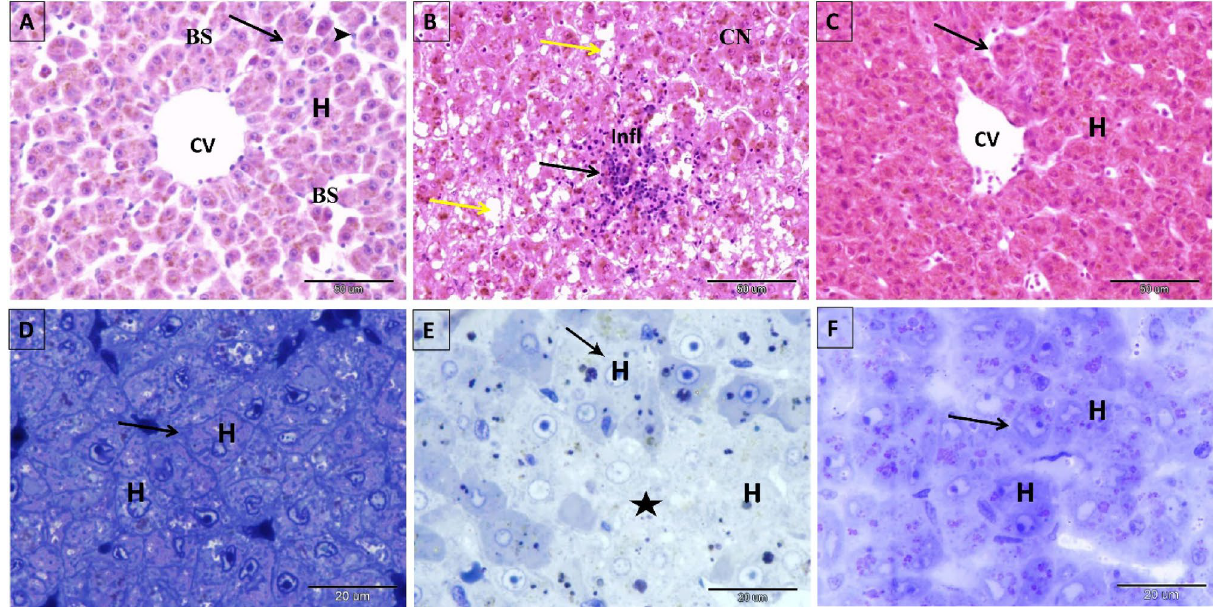
Figure 2. Photomicrograph of paraffin ( A – C ) and semi-thin ( D – F ) sections in the liver of control, 4-NP-intoxicated, and 2.5% NSS treated groups. ( A ) Control liver sections displaying healthy hepatocytes arranged in hepatic cords radiating from the central vein (CV) and were separated by blood sinusoids (BS), which were lined by endothelial cells (arrow) and kupffer cells (arrowhead). Hepatocytes (H) appeared as polyhedral cells with acidophilic cytoplasm and a vesicular, spherical nucleus in the center. ( B ) 4-NP-intoxicated liver section showing hepatocytes with widespread fatty degeneration as clear, small vacuoles filling the majority of hepatocytes’ cytoplasm (yellow arrow). Other hepatocytes exhibited stages of coagulative necrosis, which are characterized by deeply stained acidophilic cytoplasm and pyknotic, karyorrhexis, or nuclei loss (CN). A mononuclear inflammatory cell infiltration (infl) confirms the presence of acute hepatitis (black arrow). ( C ) The hepatic structure, hepatocytes (H), and central vein (CV) of the 2.5% NSS treated group were comparable to those of the control group, with no inflammatory cell infiltration or vacuolar fatty degeneration (arrow). ( D ) Semi-thin section of liver of control Clarias gariepinus displayed healthy hepatocytes (H) with a centralized nucleus and distinct cell outlines (arrow). ( E ) Semi-thin section of 4-NP-intoxicated Clarias gariepinus displaying cloudy swelling in the hepatocytes (H) with clear pale cytoplasm (arrow) and area of ballooning degeneration (star) containing hepatocytes with faintly stained cytoplasm, absence of cell outlines, and eccentric, pyknotic, or absent nuclei. ( F ) Semi-thin section of the liver of 2.5% NSS treated Clarias gariepinus demonstrates an improvement in the histological appearance of the liver, with more healthy, deeply stained hepatocytes (H) containing round vesicular nuclei and distinct cell outlines (arrow). Scale bar in ( A – C ) = 50 μm and stained with Hematoxylin and Eosin stain; ( D – F ) = 20 μm and stained with Toluidine blue